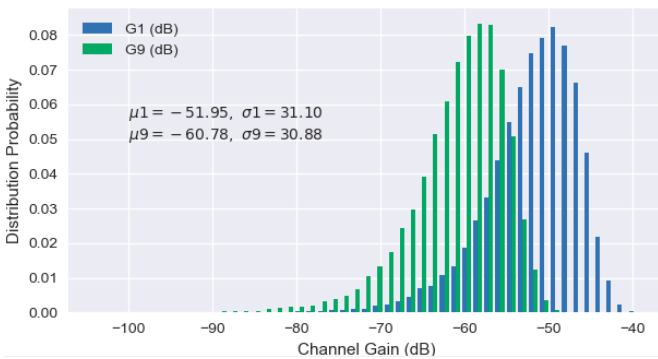
Figure 4. Frequency distribution histogram of different channel power gains.